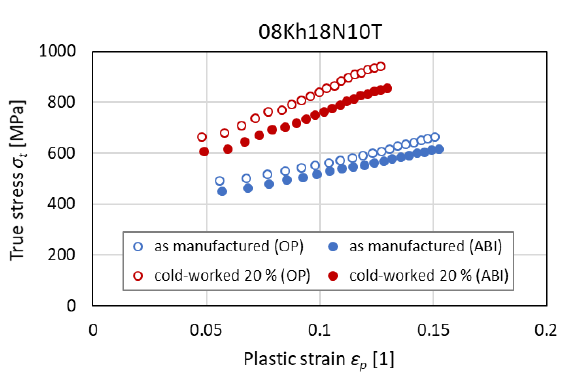
Figure 6. True stress/plastic strain curves for unde- formed a cold deformed 08Kh18N10T